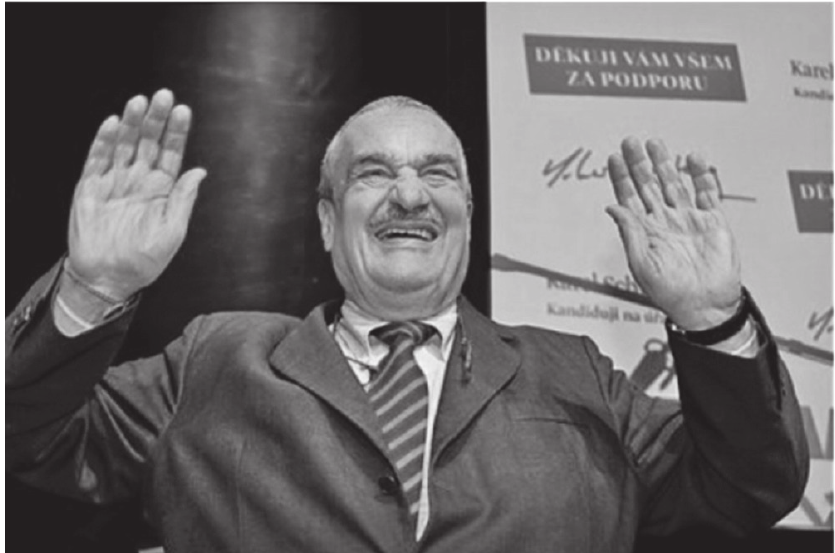
Fig. 1. Karel Schwarzenberg, Lidovky.cz , 12. 1.